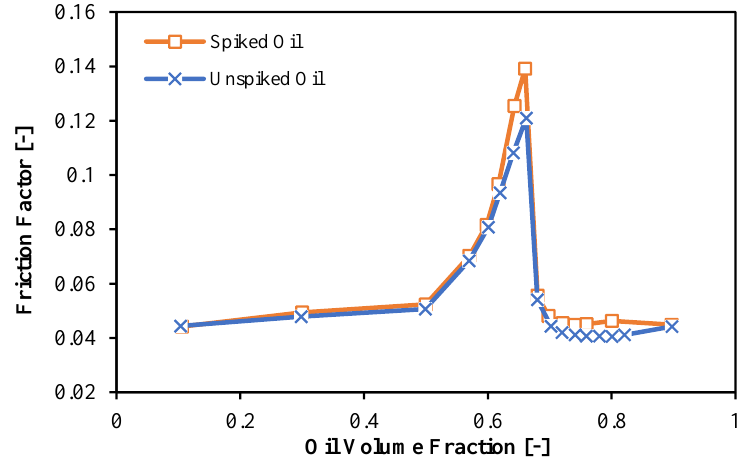
Figure 8. Inversion points of spiked oil and unspiked oil dispersions with saltwater at mixture velocity 0.66 m/s.